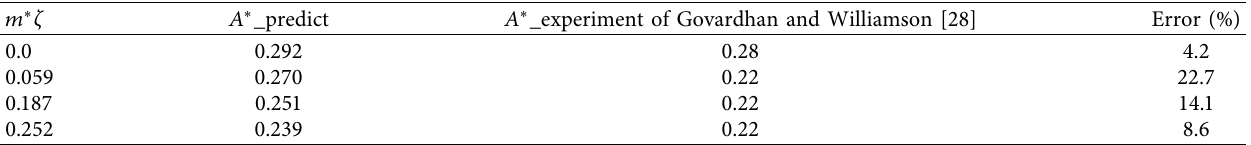
Table 9: Comparison of A ∗ at λ ∗ � 5 . 0 with experiment